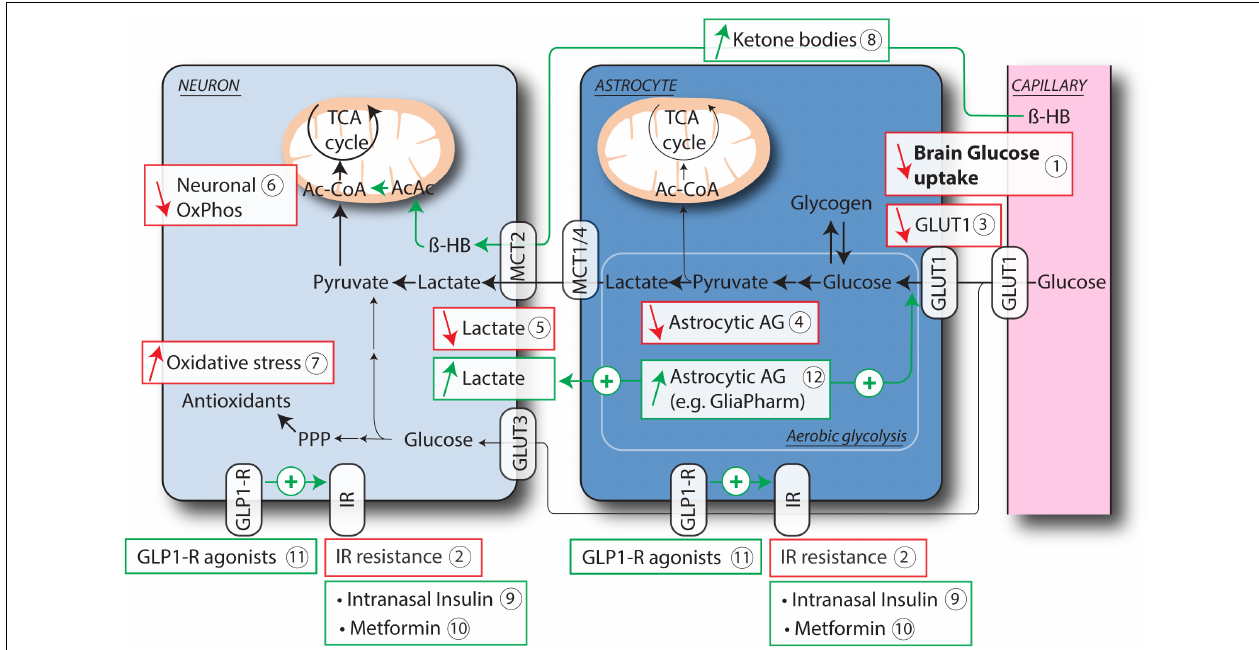
FIGURE 1 | Age-related astrocytic and neuronal deficits leading to brain hypometabolism and current therapeutic strategies. Brain glucose hypometabolism is a hallmark of aging and neurodegeneration, as shown in particular by FDG PET studies (1). Resistance to Insulin has been proposed to account, at least in part, for this hypometabolism (2). Astrocytes and neurons both express insulin receptor (IR). Other key features of brain hypometabolism include reduced expression of GLUT1 on astrocytes and endothelial cells (3), decreased aerobic glycolysis (AG) in astrocytes (4) and consequent impaired release of lactate (5), reduced mitochondrial activity in neurons (6) and increased oxidative stress (7). Therapeutic strategies that aim at restoring brain energy metabolism include the use of ketone bodies as alternative energy source for neuronal mitochondrial OxPhos, either through ketogenic diet or medium chain triglycerides (8), targeting IR resistance either directly with intranasal Insulin (9) or Metformin (10), or via activation of GLP-1R (11). Another specific therapeutic approach consists in improving astrocytic AG (12), which results in increased glucose uptake and lactate release by astrocytes. Ac-CoA, acetyl-CoA; AcAc, acetoacetate; β -HB, β -hydroxybutyrate; GLP1-R, glucagon-like peptide 1 receptor; GLUT1, 3, glucose transporter 1, 3; IR, insulin receptor; MCT1, 2, 4, monocarboxylate transporter 1, 2, 4; OxPhos, oxidative phosphorylation; PPP, pentose phosphate pathway; TCA cycle, tricarboxylic acid cycle.